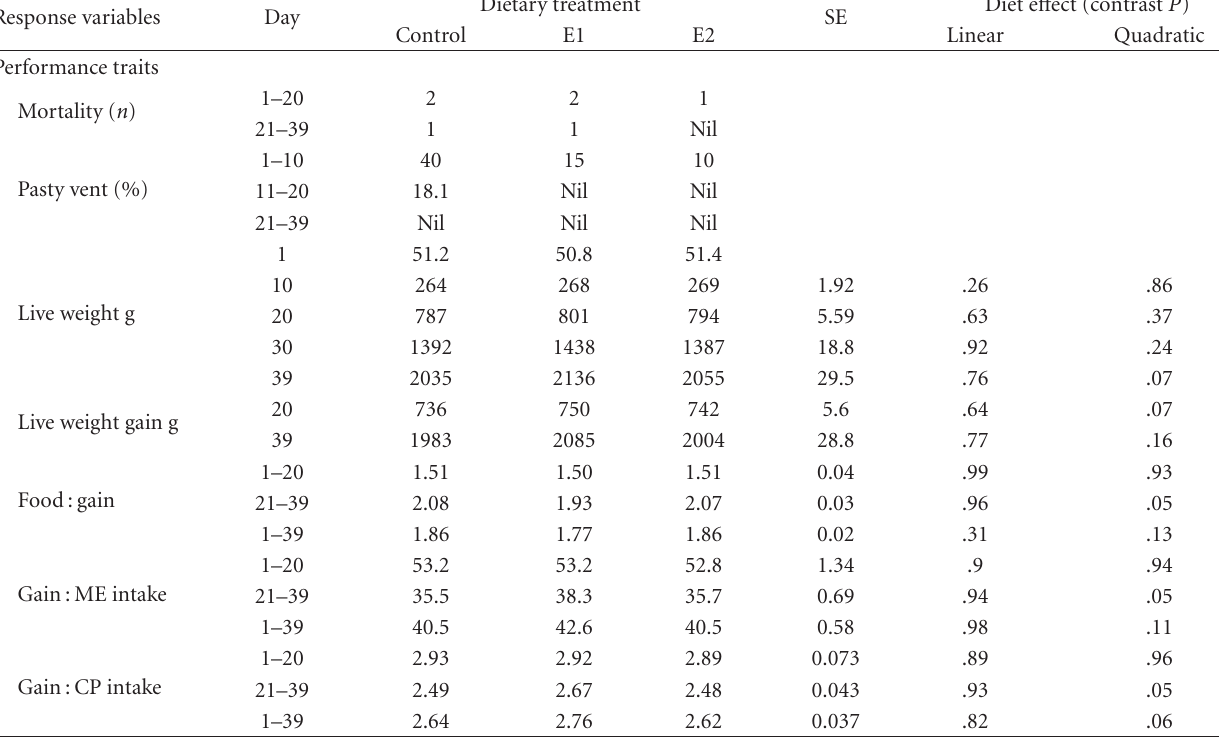
Table 3: Live performance of broilers supplemented with exogenous emulsifier in graded doses a . Response variables